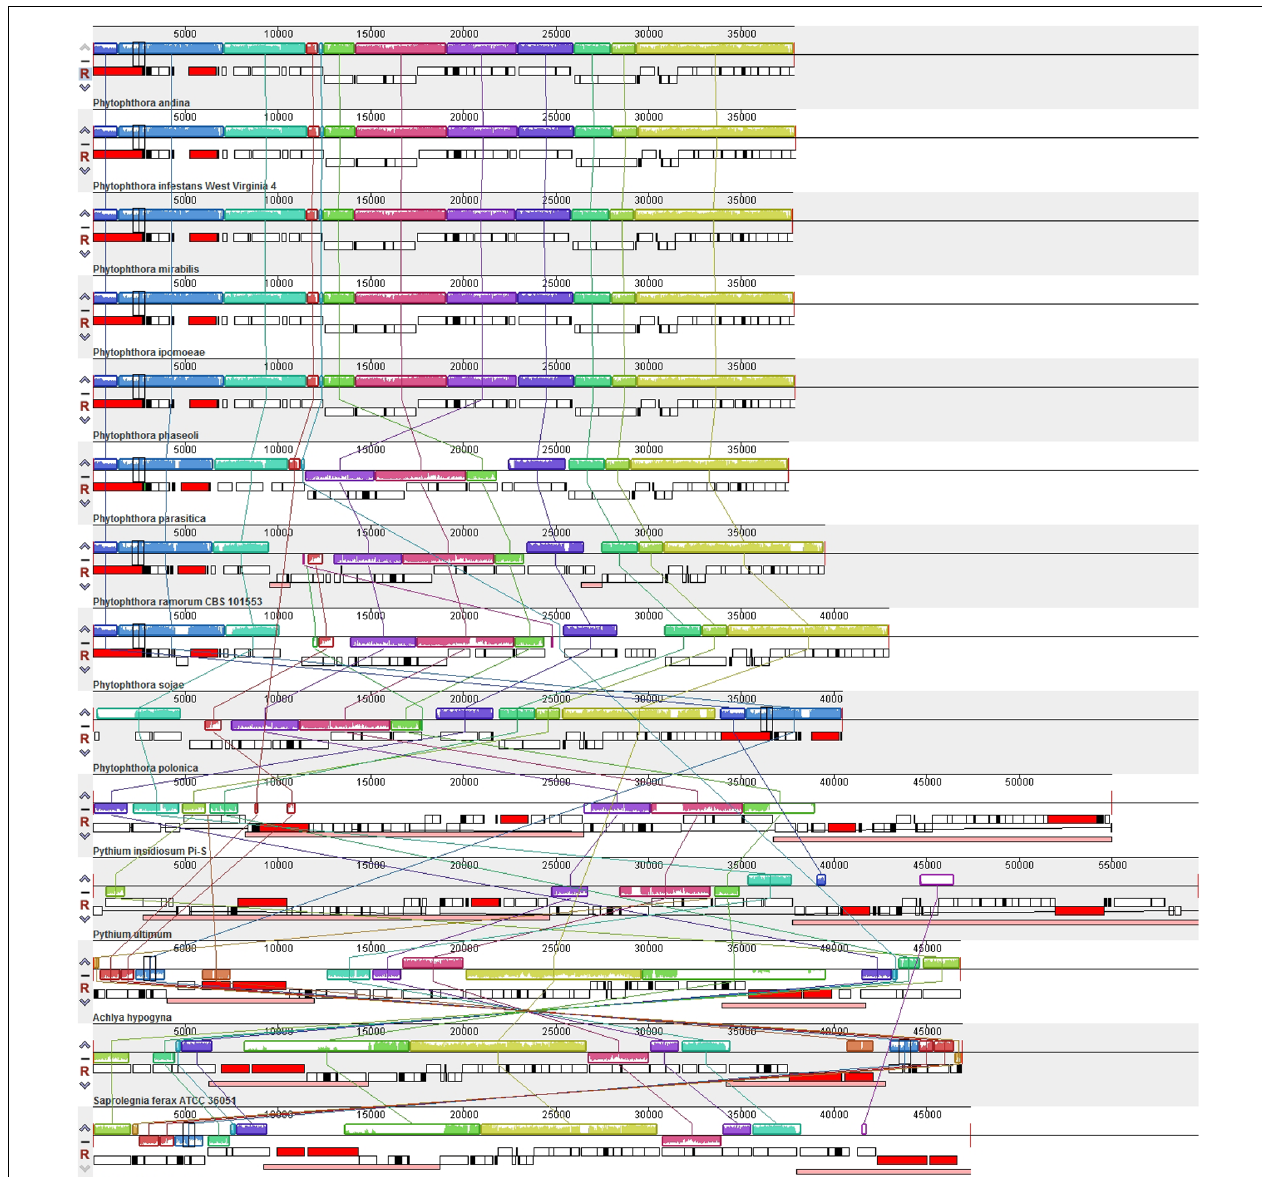
FIGURE 4 | Collinearity analysis of the genome structures of 14 mitogenomes from the Oomycetes. Collinear blocks among 14 species are identified by MAUVE. Links between these collinear blocks are indicated by the thin colored